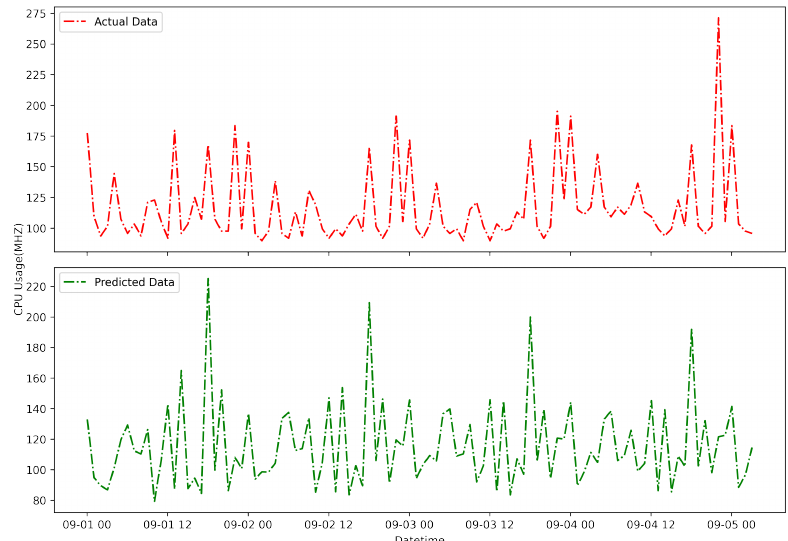
Figure 7. Behaviour of actual CPU usage and prediction result.